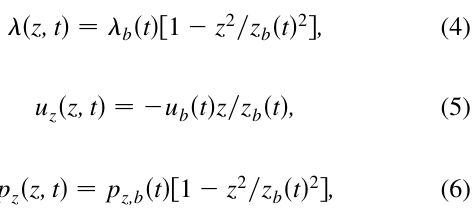
FIG. 5. (Color) Longitudinal compression ratio I (cid:4) t (cid:5) =I model (red) at multiple axial locations from Z (cid:8) (cid:1) 8 cm to Z (cid:8) (cid:2) 92 cm